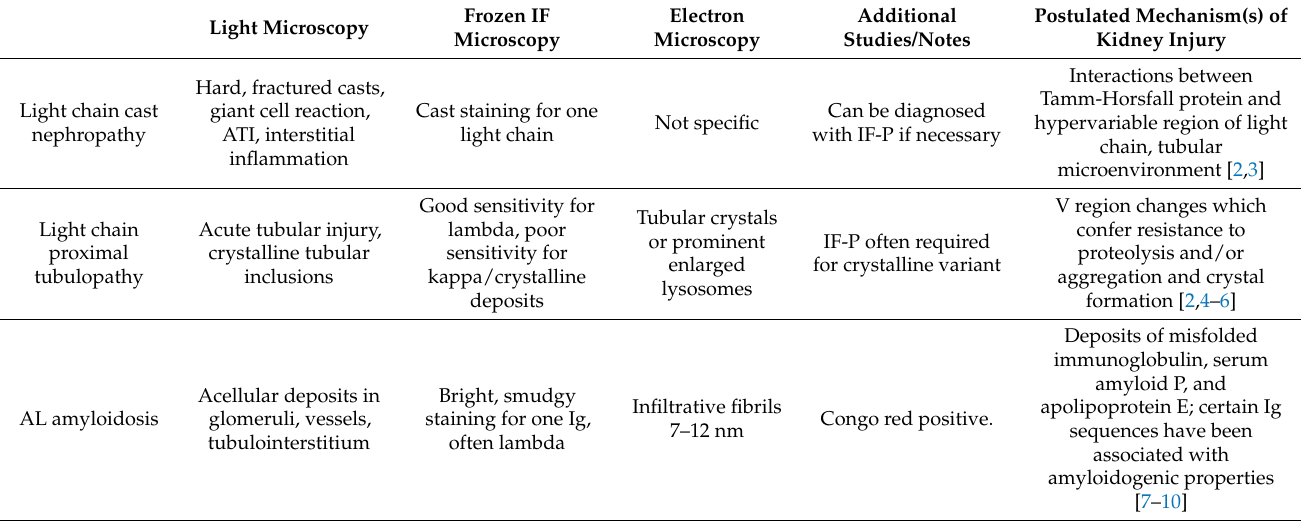
Table 1. Kidney biopsy characteristics of dysproteinemic kidney